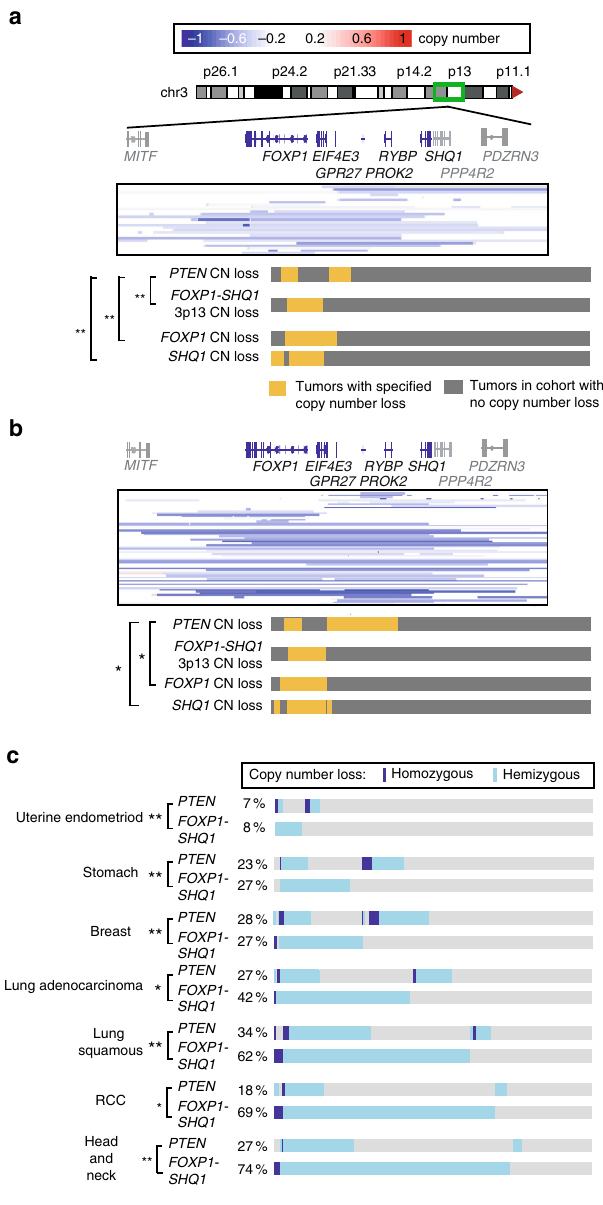
Fig. 1 3p13-14 FOXP1-SHQ1 loss is associated with PTEN loss in human cancer. a In the MSKCC primary prostate cancer cohort ( n = 146), PTEN copy number loss is enriched in tumors with copy number loss of FOXP1 , SHQ1 , and the 3p13-14 locus spanning SHQ1 to FOXP1 (homozygous or hemizygous). The boxed heat map shows copy number loss per tumor in samples with copy number loss at the 3p13-14 locus. The bar graph below shows the hemizygous or homozygous copy number loss (yellow) or absence of loss (gray) of the speci fi ed gene per tumor across the whole cohort. Signi fi cance of association, Fisher ’ s exact test, * P < 0.05; ** P < 0.01. b In the TCGA prostate adenocarcinoma cohort ( n = 330), PTEN copy number loss is enriched in tumors with copy number loss of FOXP1 and SHQ1 . The boxed heat map and bar graph show copy number loss as in a . c Multiple cancer types show co-enrichment of PTEN copy number loss with FOXP1-SHQ1 copy number loss. The bar graphs show the hemizygous copy number loss (light blue), homozygous copy number loss (dark blue), or absence of loss (gray) per tumor across the TCGA cohorts. The percentage of each cohort with speci fi ed copy number loss is